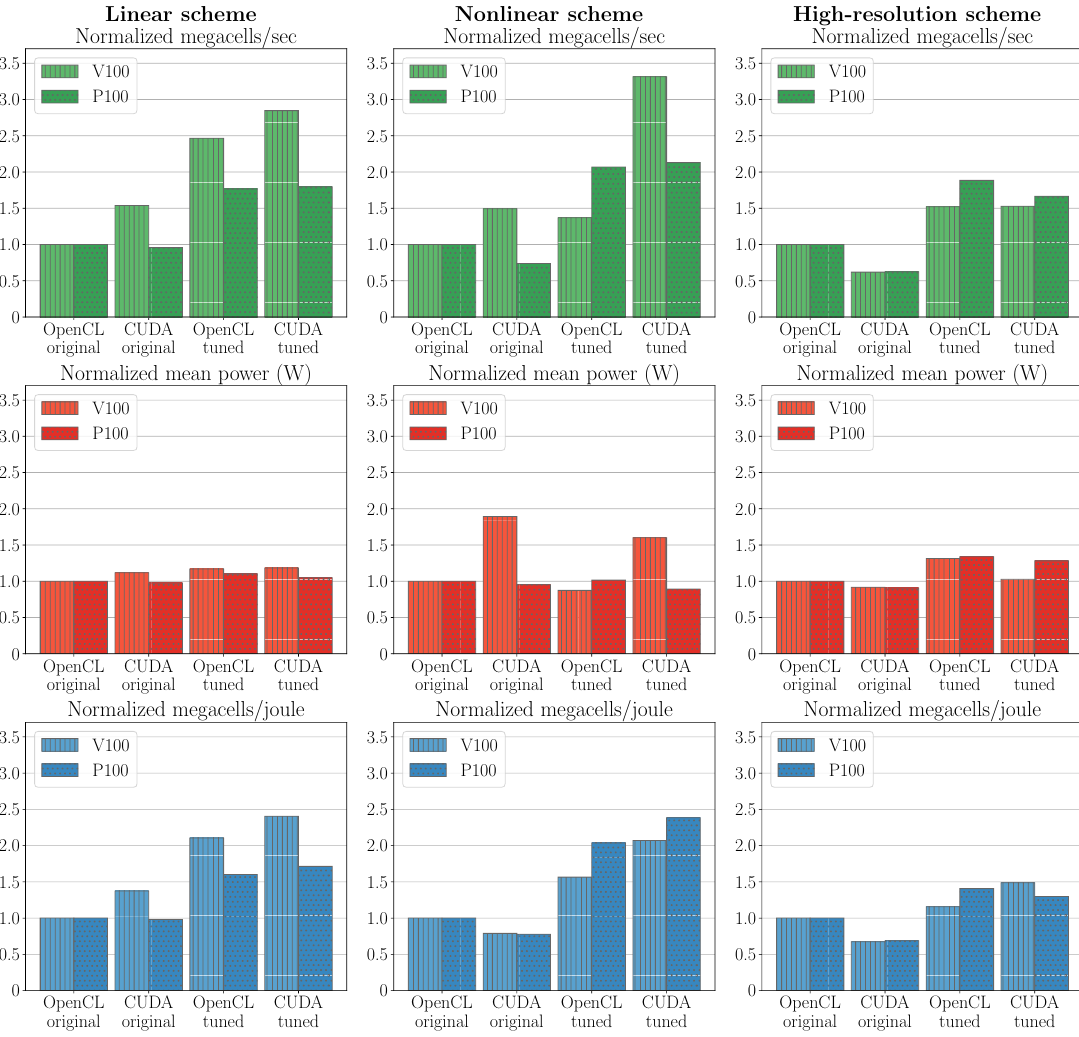
Figure 8. Comparison of original, ported, and optimized codes measured in megacells per second (top row), mean power usage (mid row), and megacells per joule (bottom row), normalized with respect to the original OpenCL implementation, for the Tesla P100 and V100 GPUs. The power is measured through nvidia-smi and represents the power consumed by the GPU only. On the V100, there are only minor differences in mean power consumption between different versions of the linear and high-resolution scheme, but CUDA uses more power than OpenCL for the nonlinear scheme. CUDA is, however, more power-efficient than OpenCL for all three tuned schemes on this GPU. On the P100, the mean power consumption is equal for all versions of the linear and nonlinear schemes, which means that power efficiency becomes equivalent to computational efficiency. For the high-resolution scheme, we see that the mean power consumption increases for the tuned codes, but the computational performance increases more, meaning that the power efficiency is still improved by